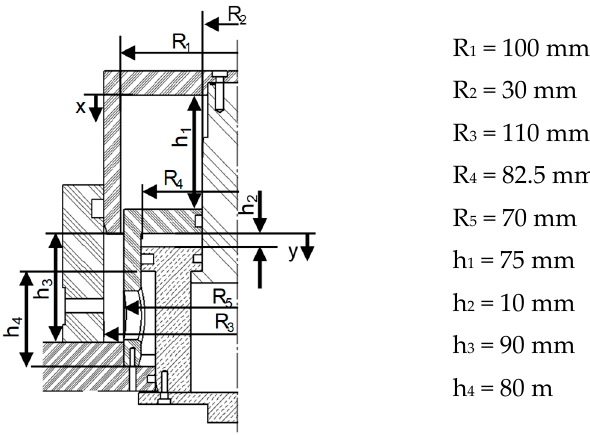
Figure 4. Necessary measurements for calculating the hammer velocity.